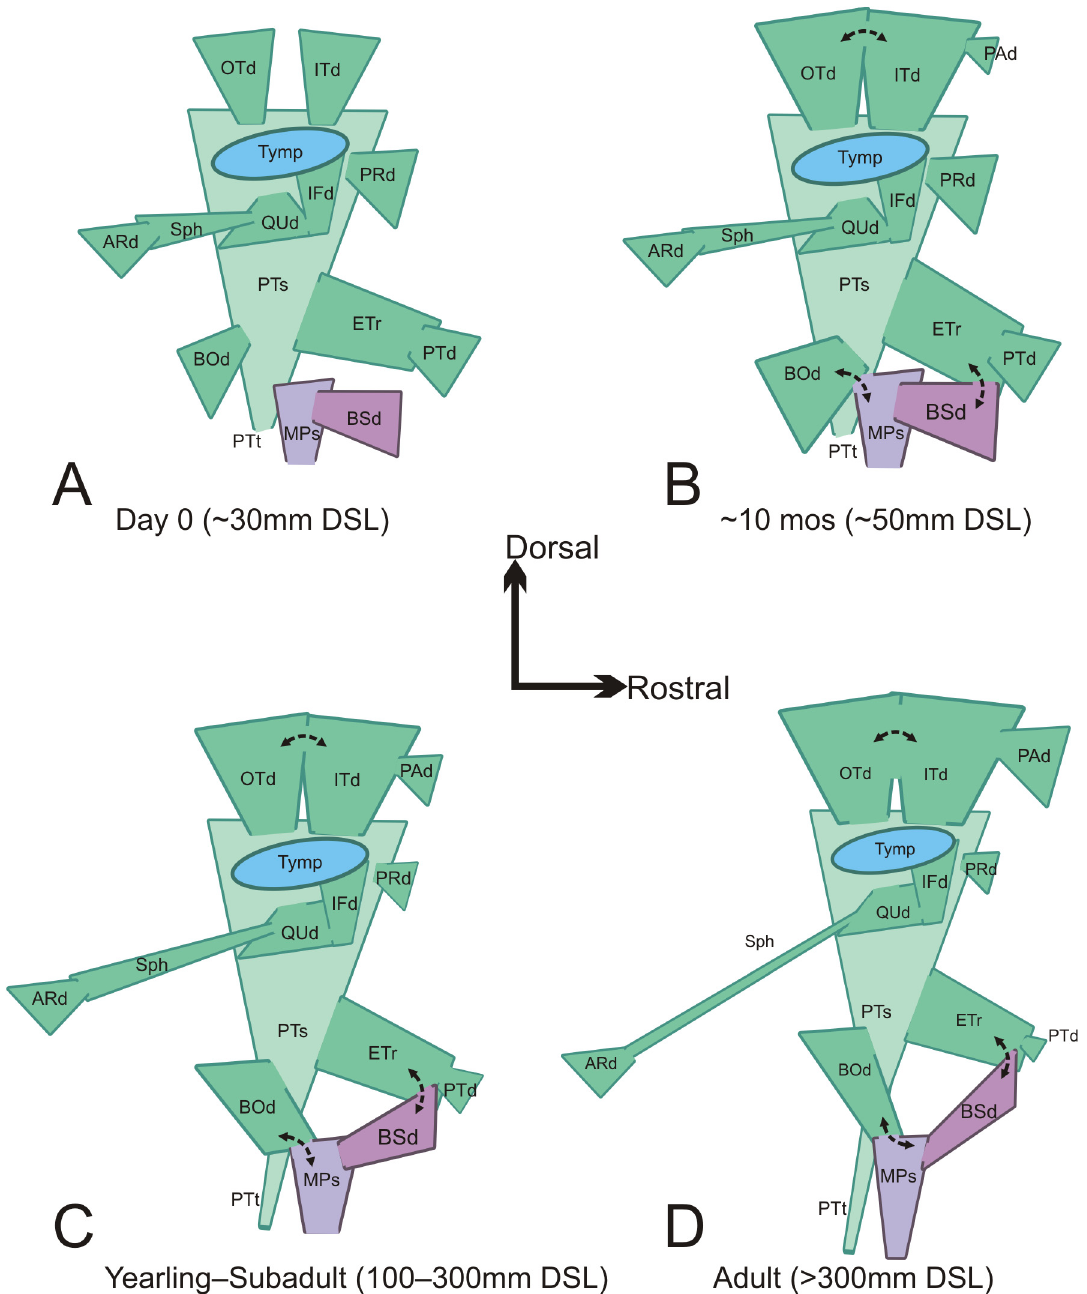
Fig 4. Schematic showing ontogenetic trends in the pharyngotympanic sinus system (green) and the median pharyngeal sinus system (purple) in right lateral view. Double ended arrows represent emergent confluences between diverticula and between the adjacent sinus systems. Ontogenetic stages are A. Day 0 (~30mm DSL), B. ~10 months (~50mm DSL), C. yearling to subadult (100 – 300mm DSL), and D. adult ( > 300mm DSL). ARd , articular diverticulum; BOd , basioccipital diverticulum; BSd , basisphenoid diverticulum; ETr, recessus epitubaricum; IFd , infundibular diverticulum; ITd , intertympanic diverticulum; MPs , median pharyngeal sinus; OTd , otoccipital diverticulum; PAd , parietal diverticulum; PRd , prootic diverticulum; PTd , pterygoid diverticulum; PTs , pharyngotympanic sinus; PTt , pharyngotympanic tube; QUd , quadrate diverticulum; Sph , siphonium; Tymp , tympanum.